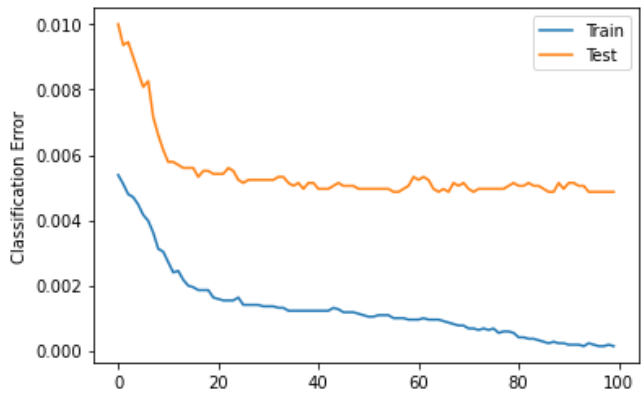
Figure 6. Classification error of XGboost.